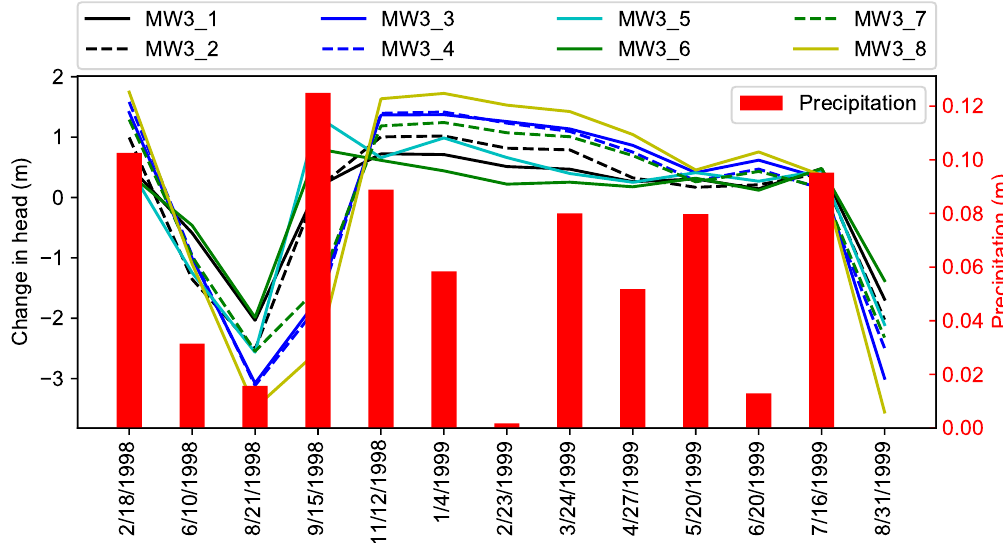
Figure 2. Change in head in response to precipitation over time. Here, hydraulic heads are plotted after removing their linear trends. Precipitation data: Waco Regional Airport [19].